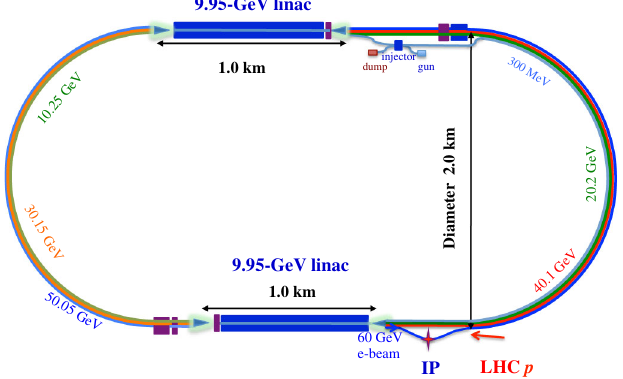
FIG. 7. BNL’s design of 60 GeV ERL for the LHeC linac-ring collider